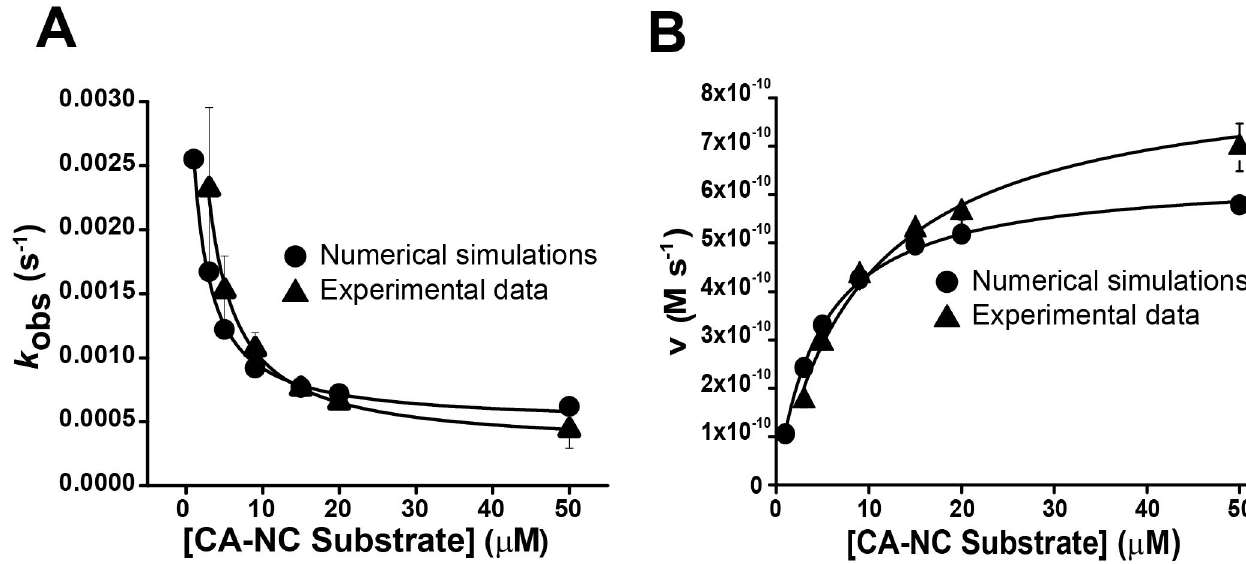
Fig 7. Confirmation of the plausibility of Scheme 3 through comparison between experimental and simulated data. (A) Dependence of experimental (triangles) and simulated (circles) k obs on the concentration of the CA-NC substrate. The experimental values were obtained as in Fig 4 and represent the mean ± standard error (n = 4). The simulated data were obtained from numerical simulations using Scheme 3 and the rate constants obtained from time course experiments. The black traces represents the best fit of Eq 3. (B) Dependence of the experimental (triangles) and simulated (circles) steady state rate v on the concentration of the CA-NC substrate. The experimental values were obtained as in Fig 5 and represent the mean ± standard error (n = 4). The simulated data were obtained from numerical simulations as in (A). The black traces represents the best fit of the Michaelis-Menten equation.